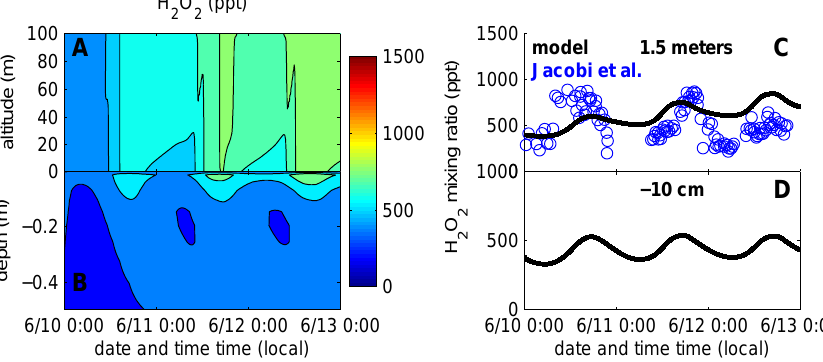
Fig. 9. Model predicted H 2 O 2 for the base case. Model results are compared with measurements taken in June 2000 originally published by Jacobi et al. (2004) (panel c ).